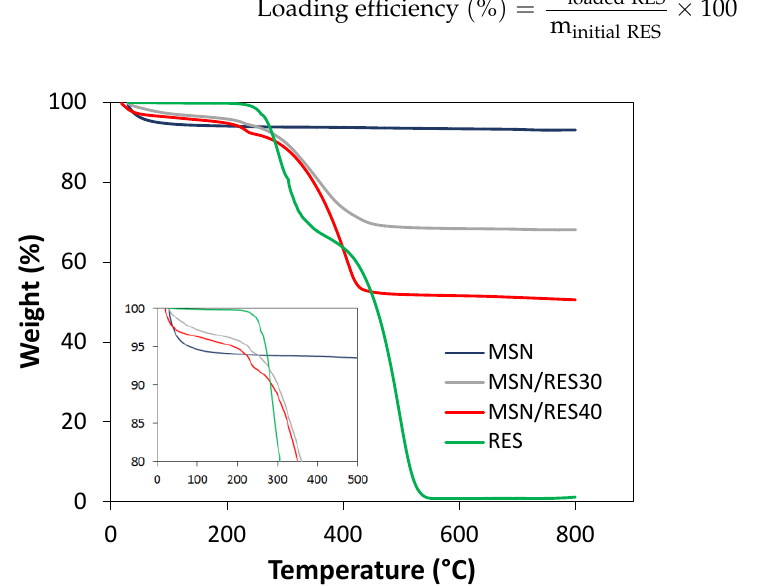
Figure 2. TGA curves of pristine MSN, resveratrol (RES), and loaded MSN/RES30 and MSN/RES40 samples.